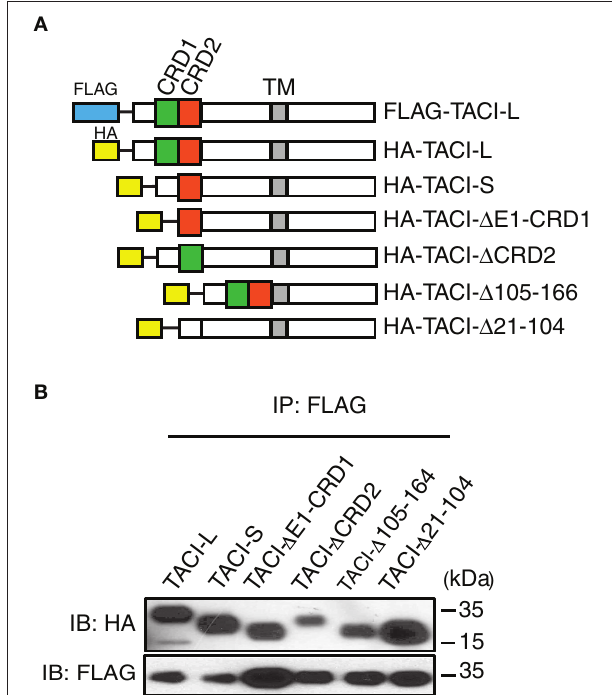
FIGURE 3 | (A) TACI variants with diverse deleted extracellular domains retain capacity for complex assembly. Upper panel shows HA labeled-TACI deletion mutant products: Full length TACI-L, TACI-S (minus CRD1), exon 1 and CRD1 ( 1 E1-CRD1), CRD2 ( 1 CDR2), minus the remaining extracellular 59 amino acids ( 1 aa105-164) and excision of both CRD1 and CRD2 ( 1 21-104) were constructed. (B) Constructs were transfected into HEK-293T cells along with TACI-L-FLAG; after cell lysis, precipitates were harvested with anti-FLAG sepharose beads, and complexes in lysates examined after PAGE and immunoblotting using an anti-HA antibody. FLAG expression was tested as control (lower panel). Data are representative of 3 independent